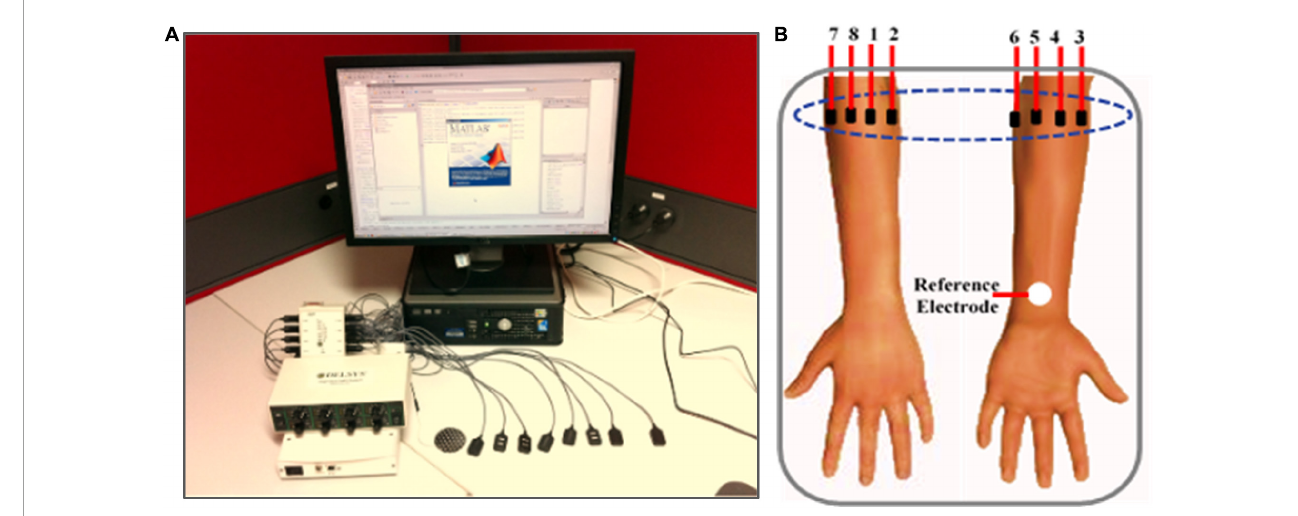
FIGURE1 (A) EMG data acquisition system (Delsys Inc.) setup; (B) electrodes placements on the anterior and posterior on the participant’s right arm (Khushaba and Kodagoda,